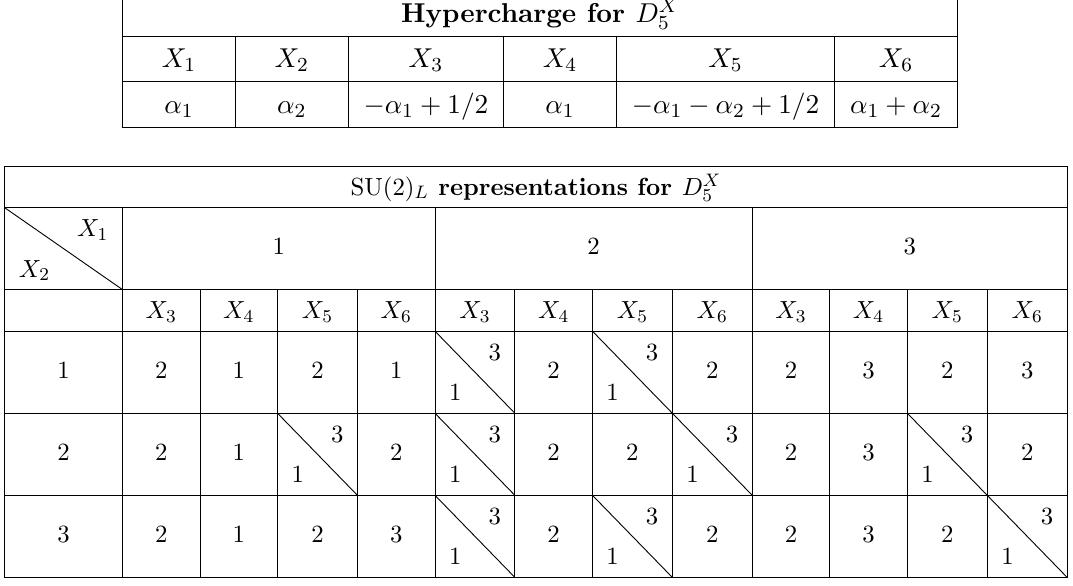
(T5-vii and T5-x) in (cid:12)gure 8. 5